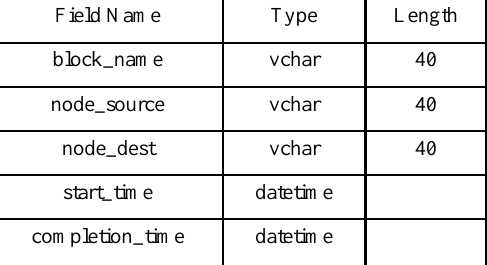
Table 4. The structure of